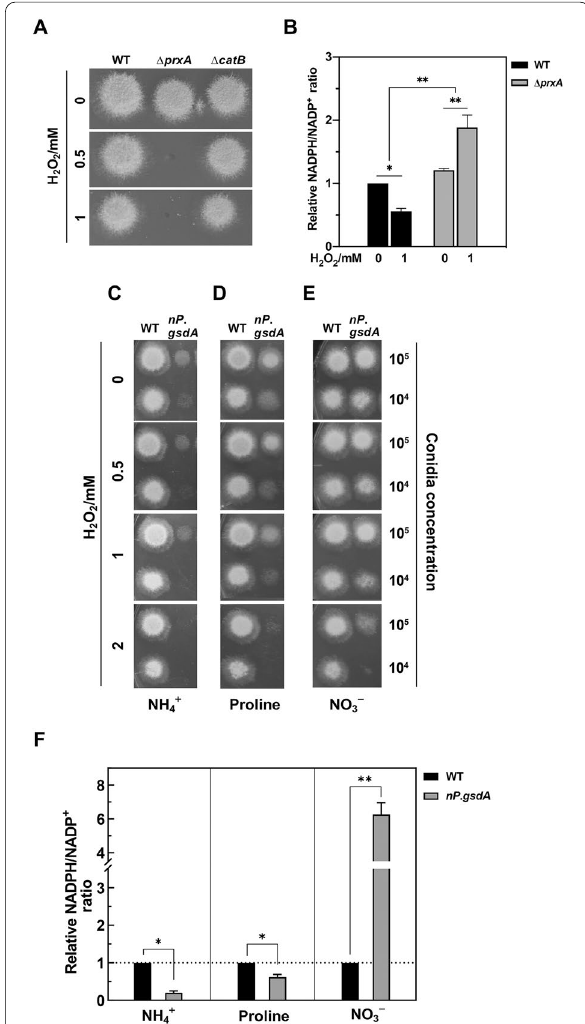
Fig. 1 A. nidulans PrxA in tandem with G6PD is essential to fungal ROS defense. A Effects of disrupting prxA and catB on